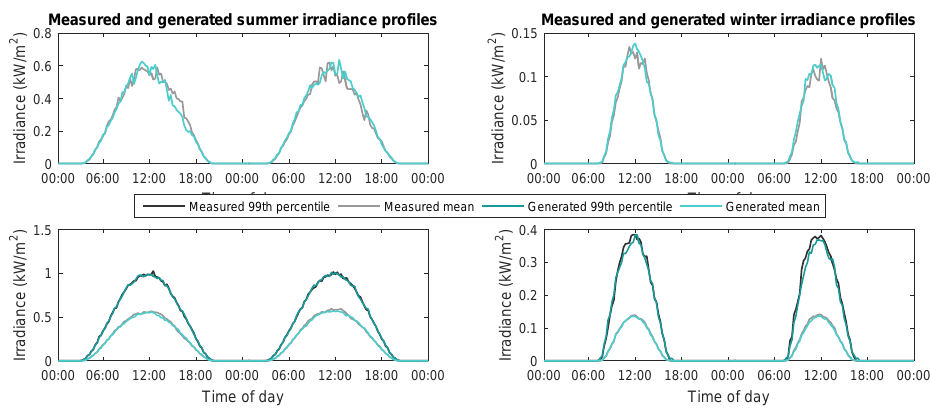
Figure 8. Comparison of measured and generated profiles of 30 ( top ) and 300 ( bottom ) random two day profiles in summer and